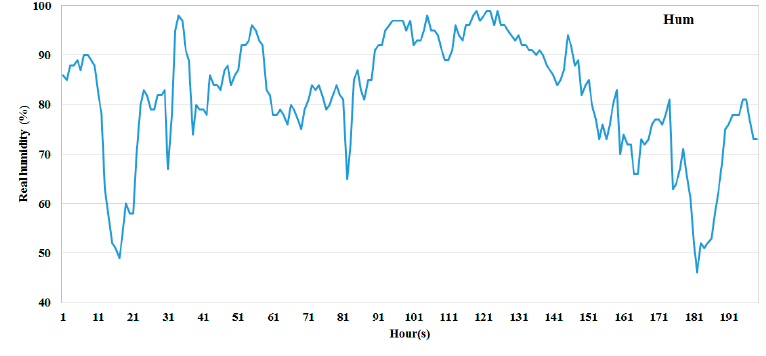
Figure 4. Humidity data information (%).